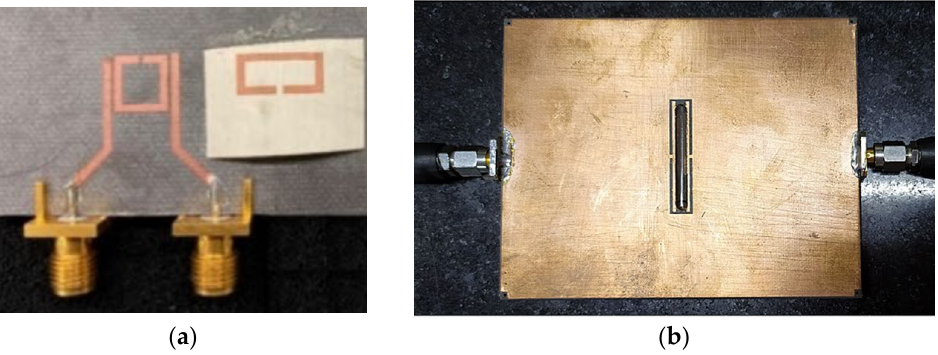
Figure 3. Examples of f r -based sensors: ( a ) Single SRR sensor with RF tag sensor concept, reprinted from [121]; ( b ) Complementary LC resonator sensor integrating a microfluidic tube, reprinted from [126].